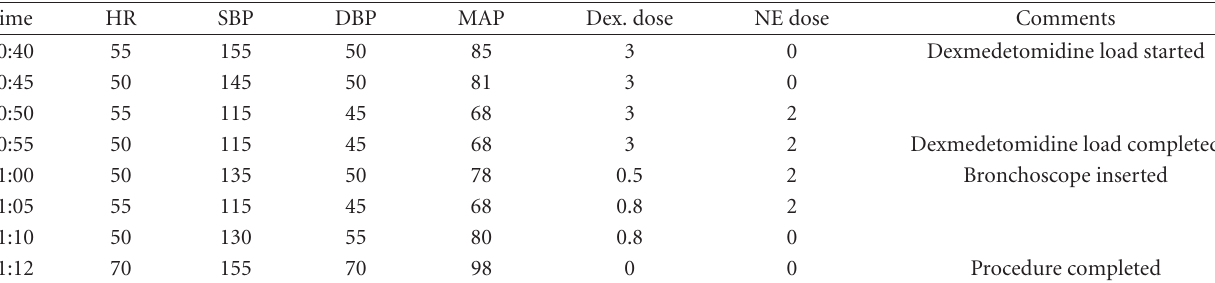
Table 1: Vital signs and infusions during tracheotomy